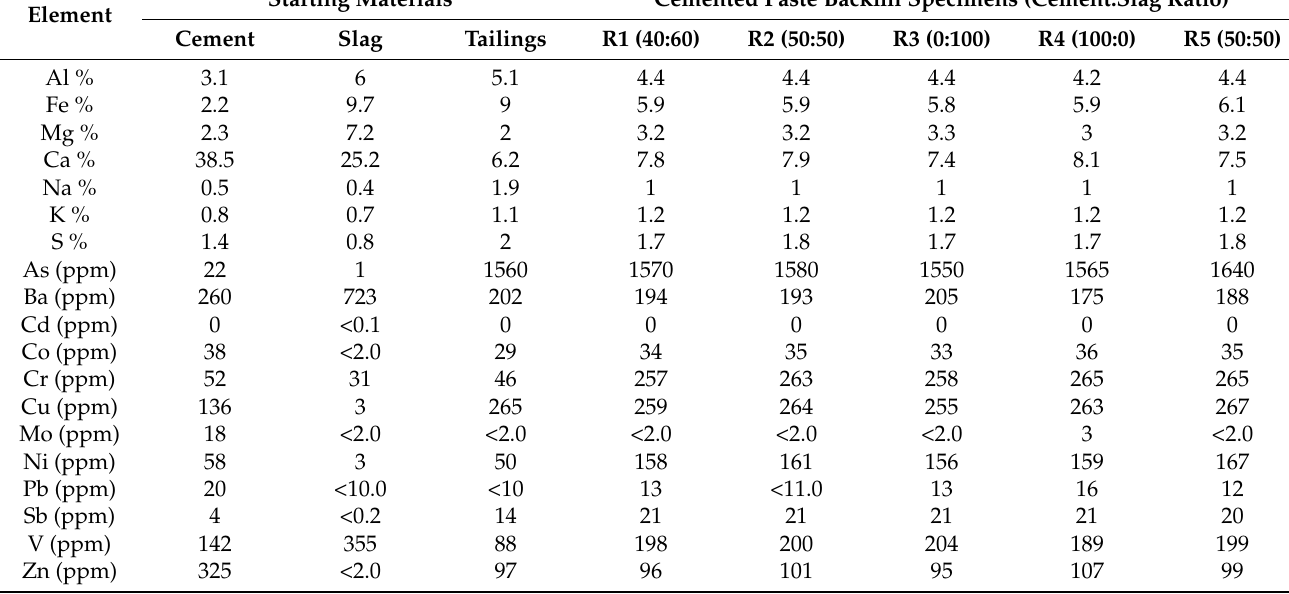
Table 3. Results of four acid leaching methods (total concentrations). The results of CPB specimens are presented as a mean value of two